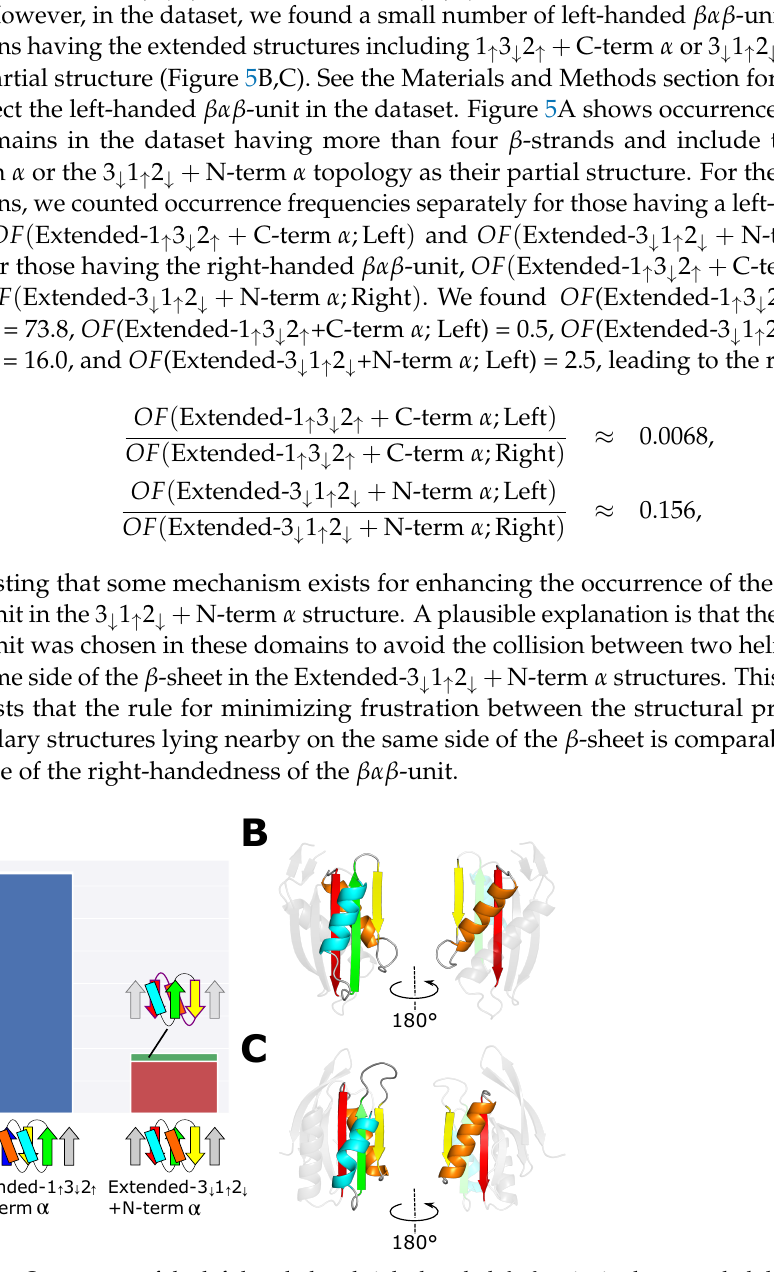
Figure 5. Occurrence of the left-handed and right-handed βαβ -units in the extended domains which include the 1 ↑ 3 ↓ 2 ↑ + C-term α or 3 ↓ 1 ↑ 2 ↓ + N-term α structure. ( A ) Comparison between occurrence frequencies of extended domains that include the 1 ↑ 3 ↓ 2 ↑ + C-term α or 3 ↓ 1 ↑ 2 ↓ + N-term α as the partial structure. The occurrence frequency of the extended 1 ↑ 3 ↓ 2 ↑ + C-term α is 74.3 among which the occurrence frequency of structures having the left-handed βαβ -unit is 0.5 (invisible in the